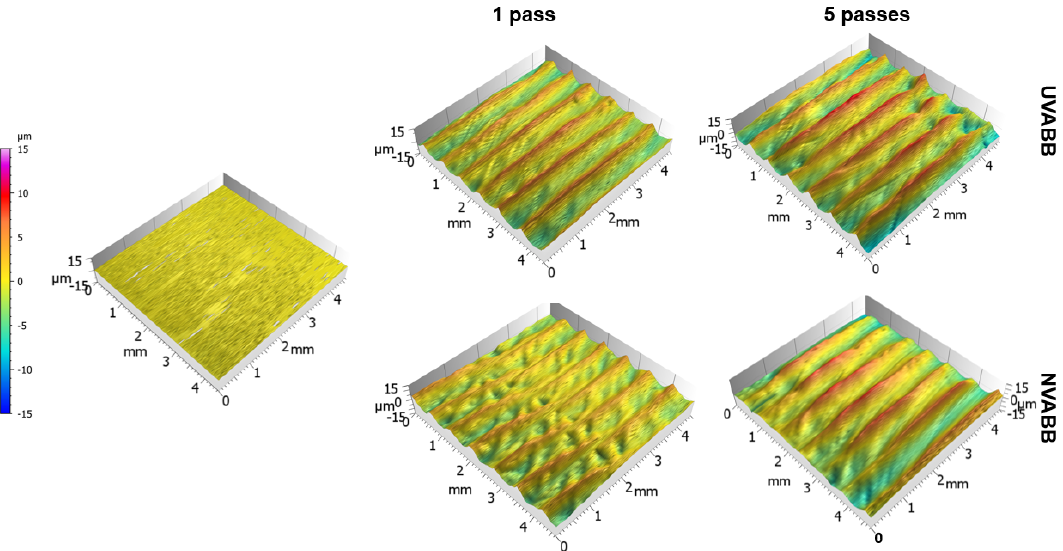
Figure 5. Three-dimensional reconstruction of the surface texture modification of material with 10% pre-existing martensite burnished along the transverse direction.